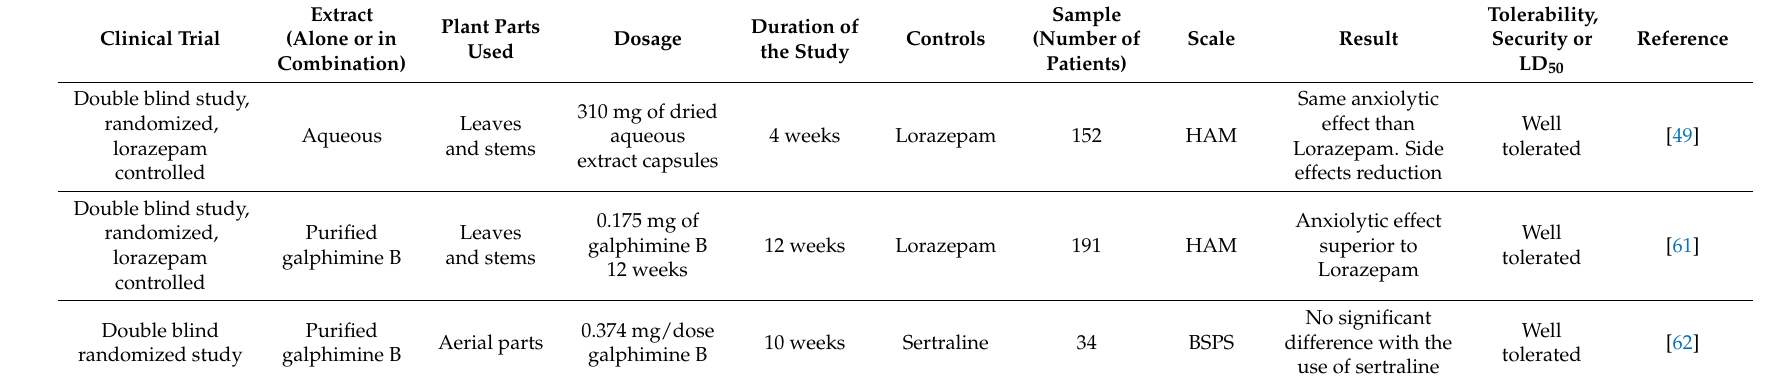
Table 3. Human clinical trials to treat anxiety related disorders reported for Galphimia glauca